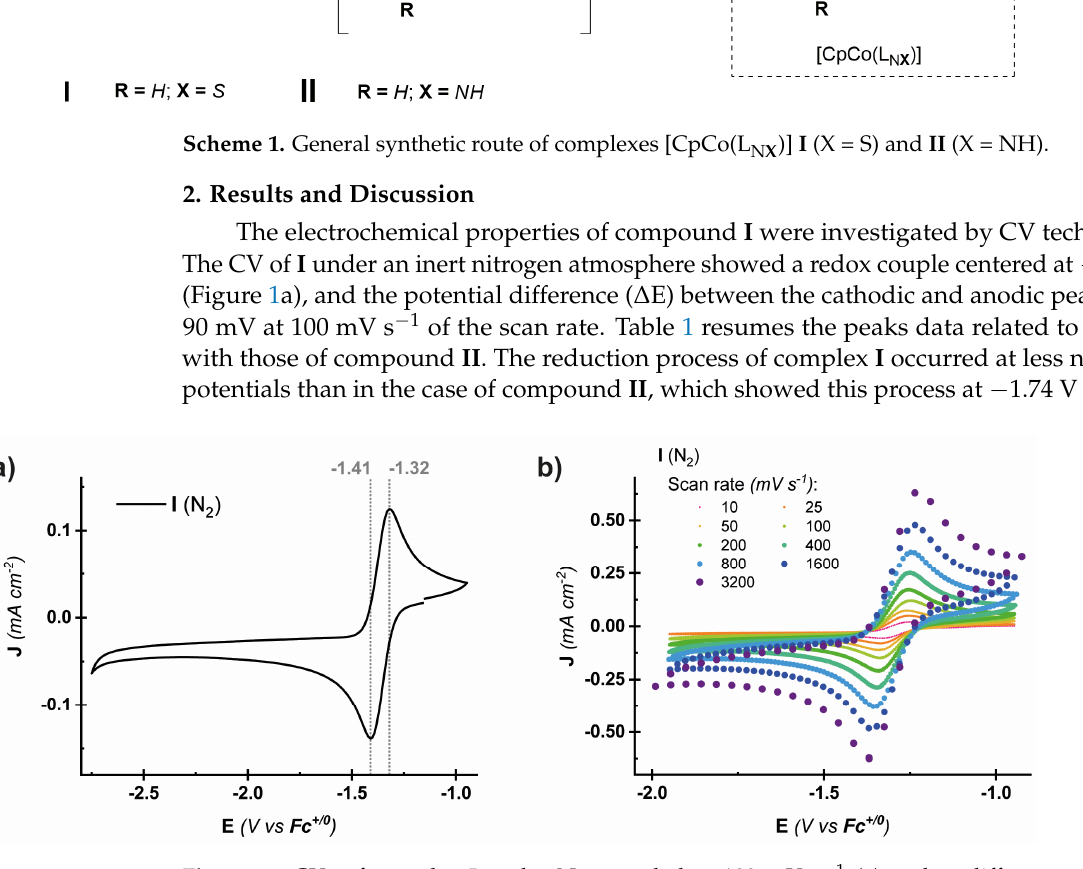
Figure 1. CVs of complex I under N 2 recorded at 100 mV s − 1 ( a ) and at different scan rates (10–3200 mV s − 1 ( b ). Table 1. Peaks analyses of complexes I and II under an inert nitrogen atmosphere.